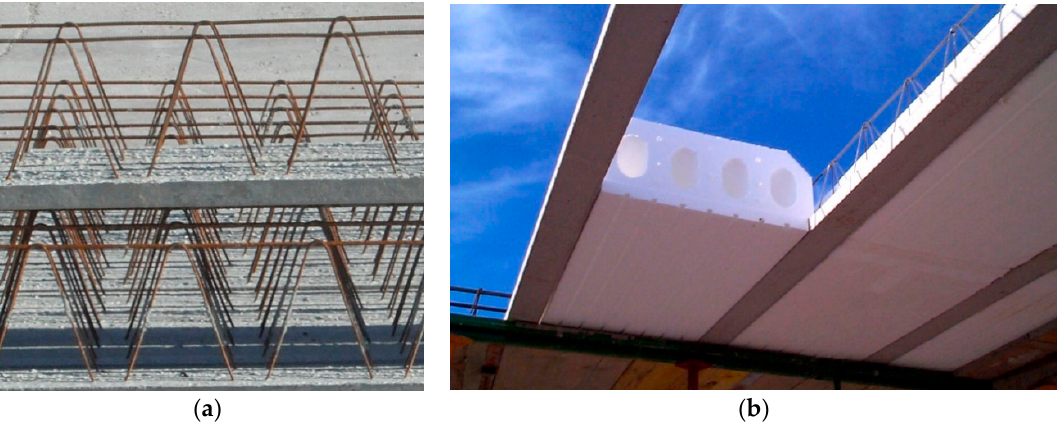
Figure 1. Reinforced RC joists (without pre-stressing) are commonly used in northern Spain areas: ( a ) lateral view of typical RC joists; and ( b ) general view of the one-way ribbed slabs, source: Iberaceros Forjados Riojanos, [4].